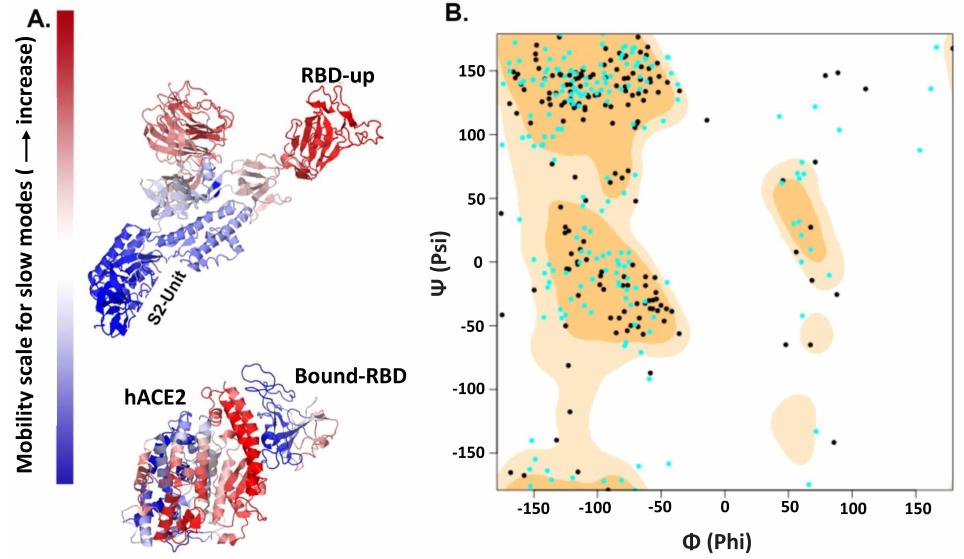
Figure 5. NMA ( A ) and Ramachandran plot ( B ) for RBD-hACE2 complexes. Cyan dots represent CoV-2-RBD AA residue phi-psi position, while black is for CoV-1 complex. We used low-frequency second normal mode to differentiate between SARS-CoV-1 and SARS-CoV-2 with and without hACE binding. ( A ) Its RBD-up conformation region in the S1-unit has higher mobility relative to other parts of the S-protein. In contrast, hACE2 binding make the RBD less mobile. ( B ) Ramachandran plot of AA residues of RBD bound with hACE2 shows significant conformational changes in the